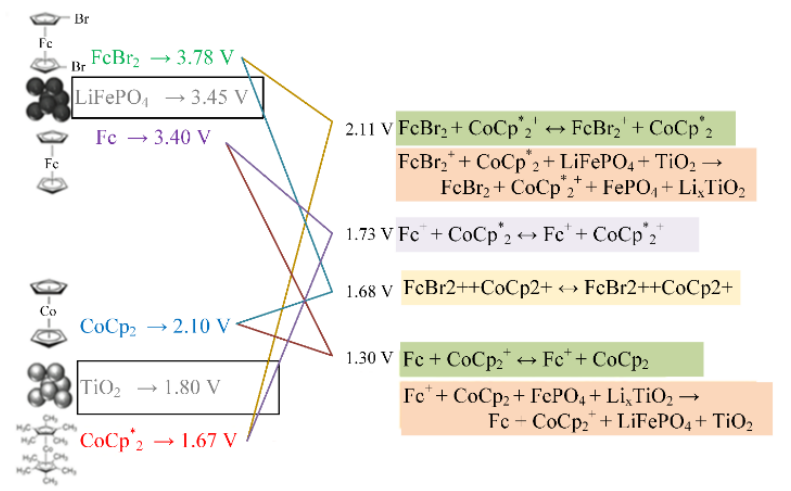
Figure 59. The chemical and electrochemical reactions in the solid active materials and mediator in the RFB, as reported by Jia et al. [161,176].